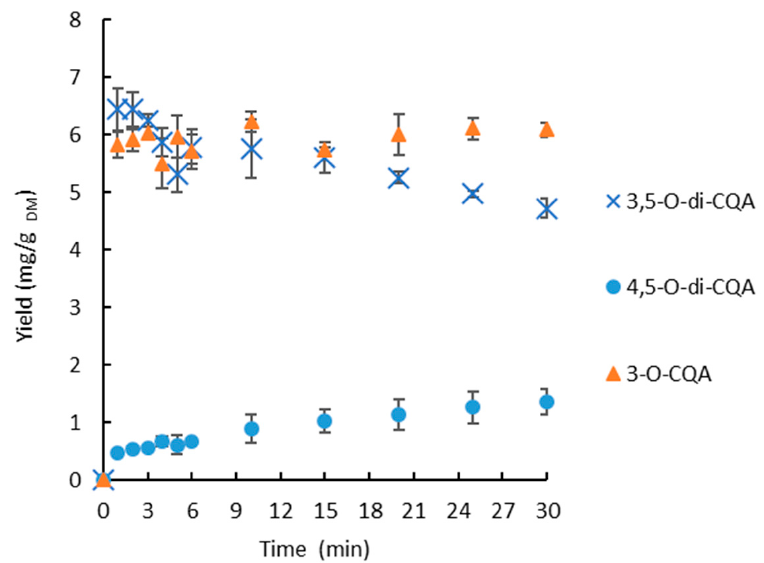
Figure 5. Thermal stability of CGAs in aqueous chicory roots extract at 90 ◦ C.